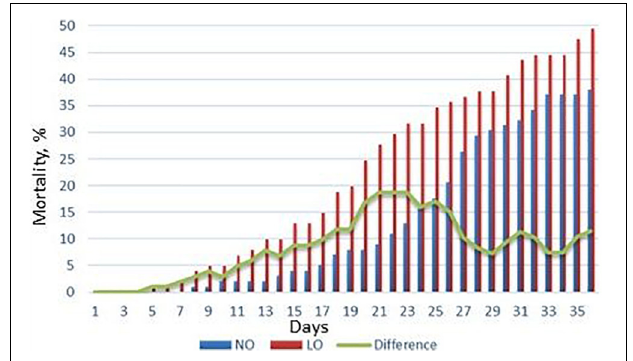
FIGURE 4 | Mortality of Atlantic salmon challenged with M. viscosa . NO, LO – groups maintained at normal and low dissolved oxygen. Data presented are mean cumulative mortality from two replicate